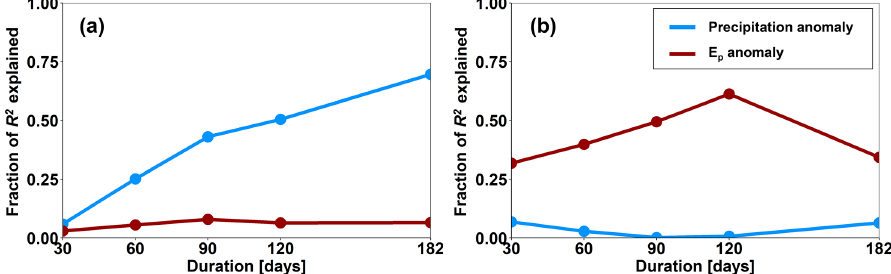
Figure 7. The fraction of multivariate R 2 (calculated by a stepwise generalized linear regression model that explains warm-season low-flow magnitudes, using all climate variables and durations) that can be explained by a precipitation (blue) or E p (red) anomaly of the specified duration. Precipitation anomalies explain most of the variation in Q min when looking at all stations and all years (a) . However, precipitation anomalies are not good predictors of low flows that occurred in the driest years (2003, 2011, 2015 and 2018), while E p anomalies are instead much better predictors of Q min variability (b)